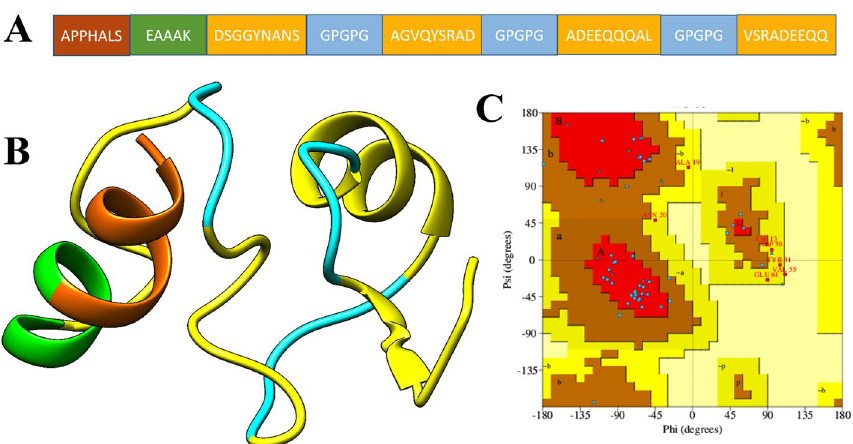
Figure 5. ( A ) Schematic presentation of vaccine construct composition, ( B ) 3D model of the predicted vaccine structure (yellow colors represent epitopes, brown is for adjuvant, green is for EAAAK linker, cyan is for GPGPG linker) and ( C ) Ramachandran plot the vaccine. The coloring scheme of the Ramachandran plot can be interpreted at https:// www. ncbi. nlm. nih. gov/ pmc/ artic les/ PMC57